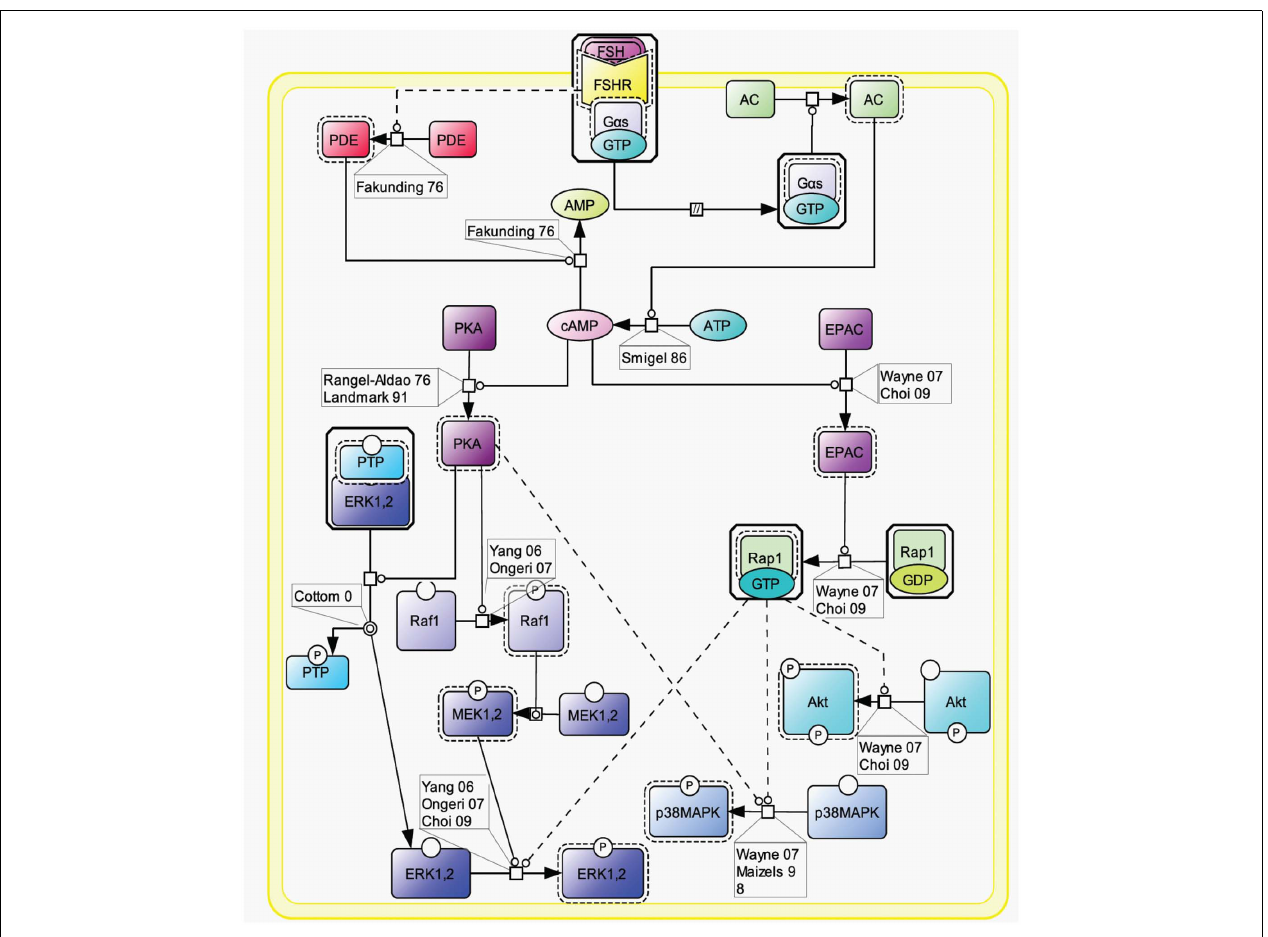
target of cAMP accumulation. Indeed, EPAC is also activated upon FSH stimulation. Both PKA and EPAC contribute to the activation of MAPK ERK and p38, whereas EPAC also leads to Akt